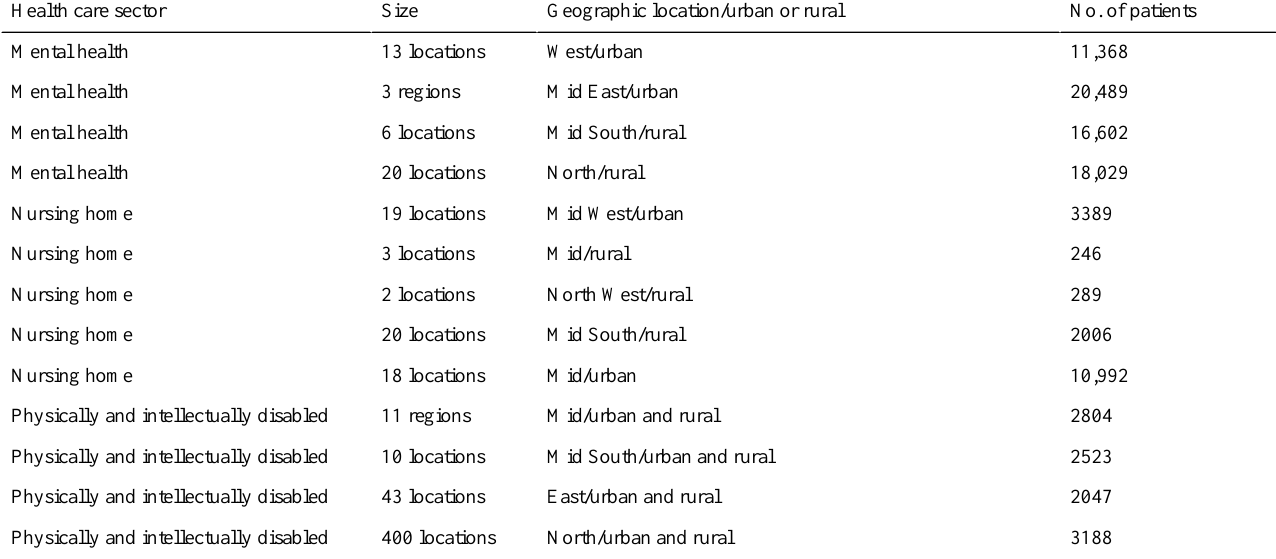
Table 1. Characteristics of the participating